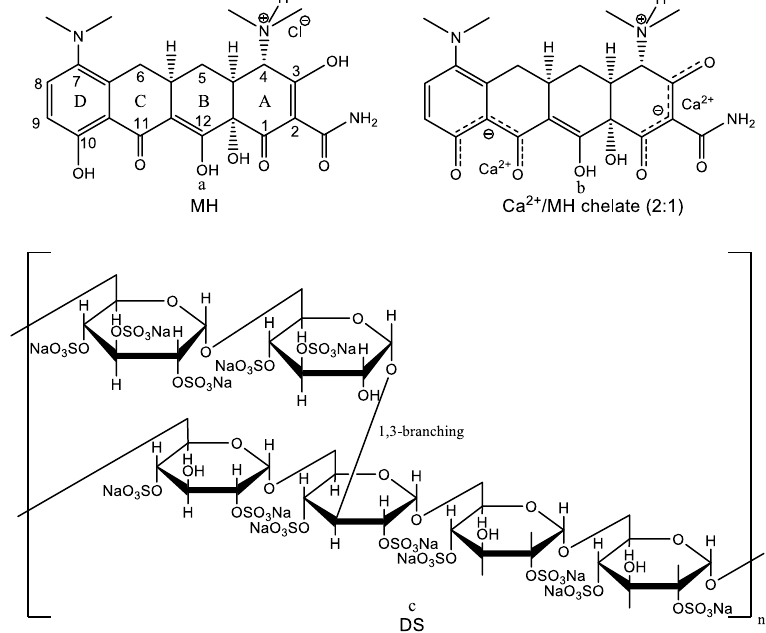
Figure 1. Chemical structures of minocycline hydrochloride ( a ), 2:1 Ca 2+ /minocycline hydrochloride chelate ( b ), and dextran sulfate sodium salt ( c ).